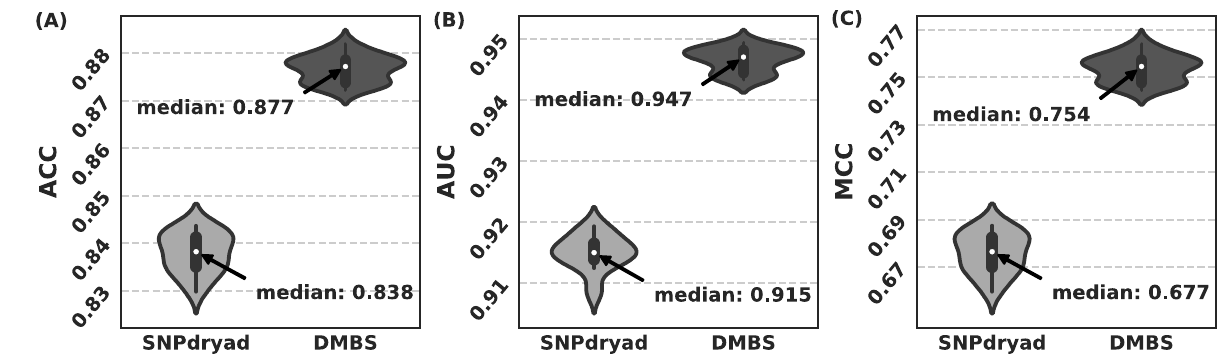
Figure 6. Comparison between DMBS and SNPdryad based on 20 repeated independent tests on the HumVar dataset. The results of DMBS and SNPdryad are represented by violin plots, based on ACC ( A ), AUC ( B ), and MCC ( C ), with each plot showing the distribution, median, and range of the corresponding metric values.